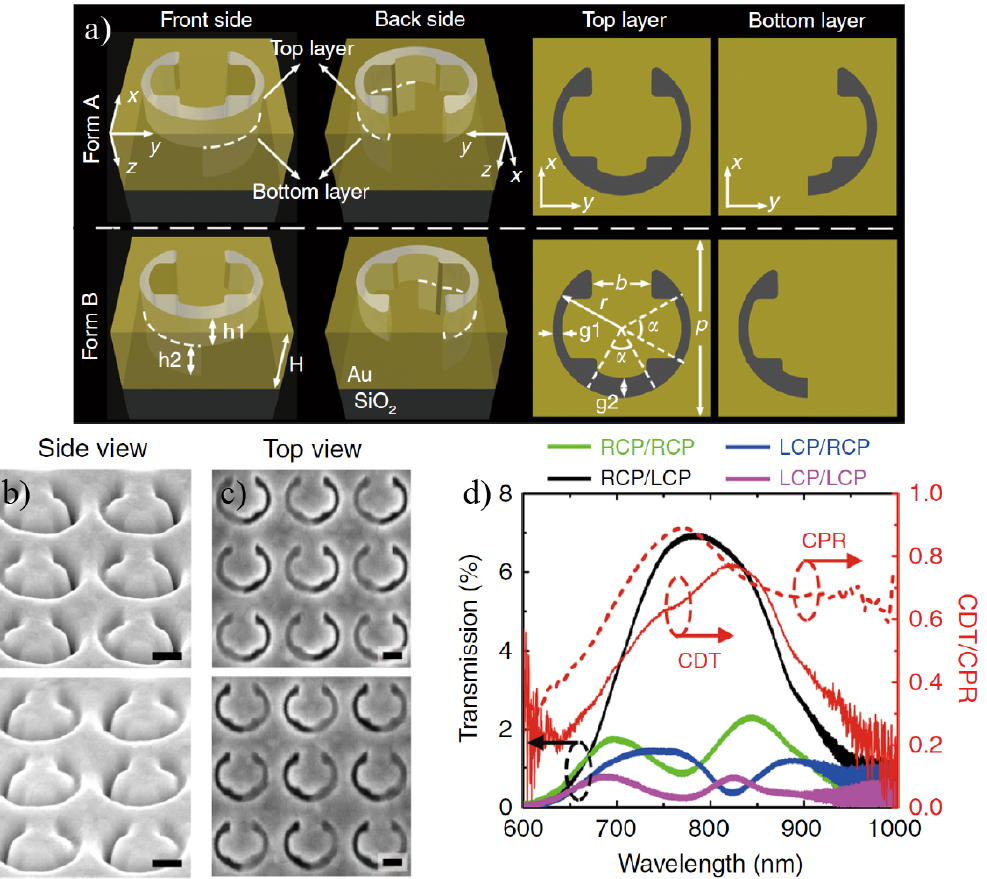
Figure 12. ( a ) Enantiomeric multilayer nanoapertures (forms A and B) are depicted. The total Au film thickness is H = 180 nm. Top and bottom building layers have aperture thicknesses of h 1 = 80 nm and h 2 = 100 nm. Other geometrical parameters are taken as p = 360 nm, r = 140 nm, b = 120 nm, α = 60 ◦ , g 1 = 20 nm, and g 2 = 40 nm. Light is considered to be vertically impinging onto the top layer and transmitted out of the bottom layer. ( b ) and ( c ) are the sideview (52 ◦ ) and top view SEM images of the multilayer nanoapertures fabricated using the FIB milling method. The scale bar is 100 nm. ( d ) Experimental values of the transmission, CDT and CPR spectra of the nanoapertures in Form A for different incident/output handedness combinations. Reproduced with permission from ref.